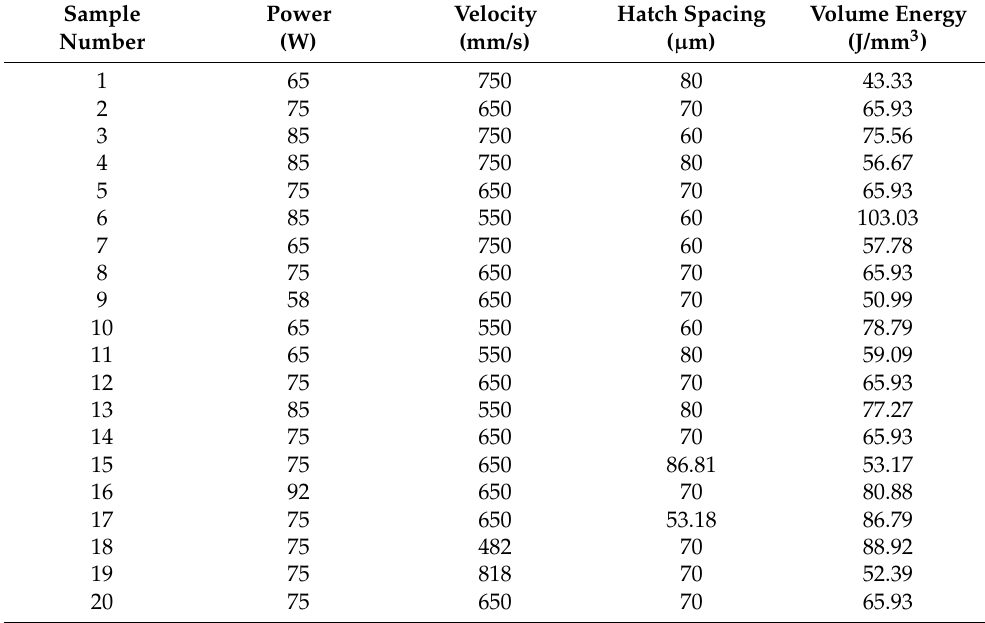
Table 1. Experimental design including 3 printing parameters and 5 levels for each parameter; 6 central points were used to improve the modeling and prediction precision.